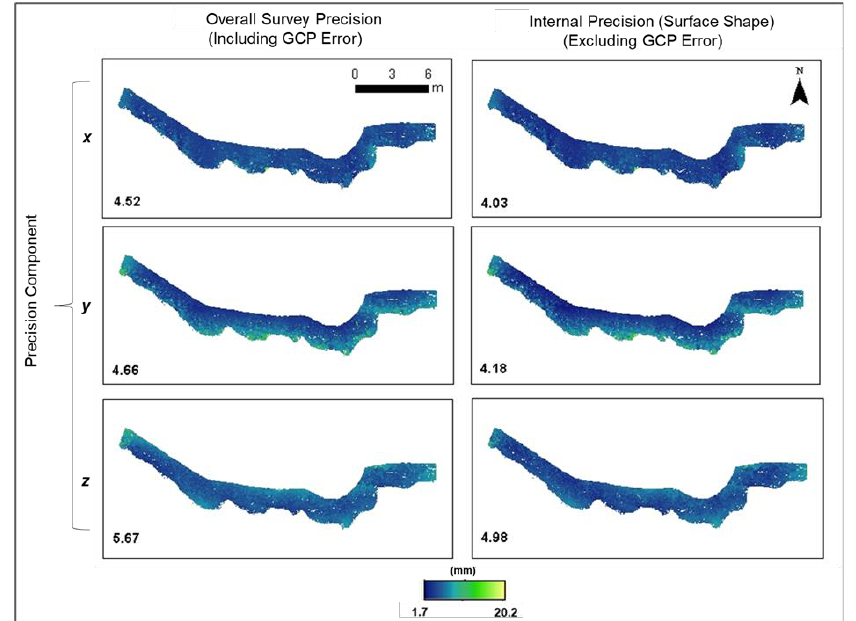
Figure 11. Precision error maps separated into x , y and z dimensions for Silverdale. Overall survey precision including georeferencing error and internal precision (surface shape error) excluding any georeferencing error are displayed in two columns. Mean precision (mm) is displayed on the bottom left of each map.